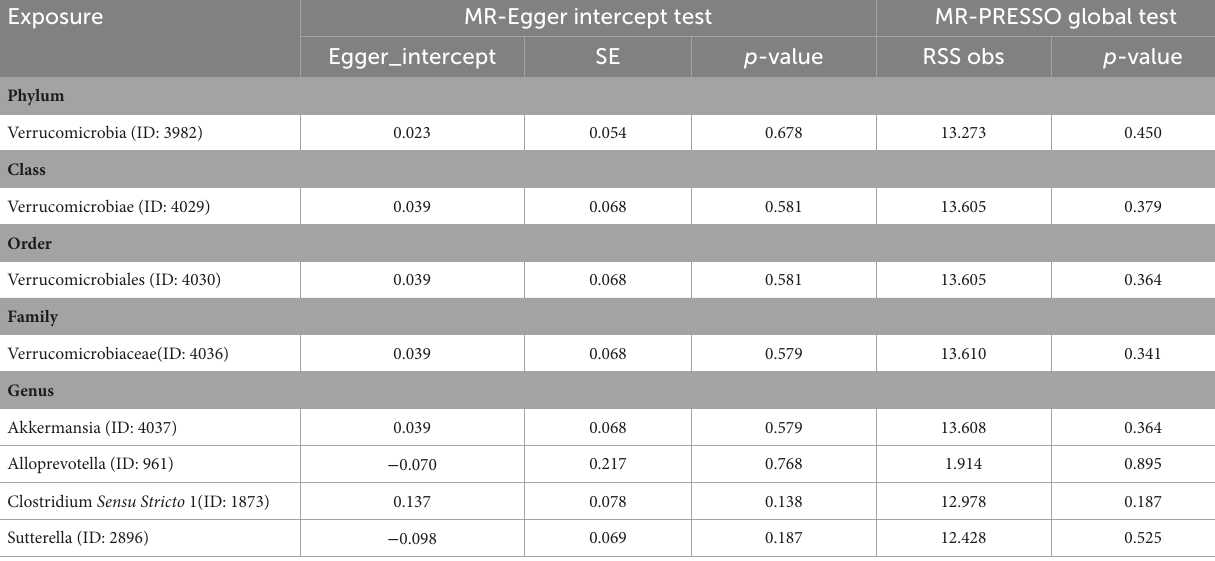
TABLE 4 Horizontal pleiotropy analysis for IVs of 8 GM taxa associated with focal epilepsy.